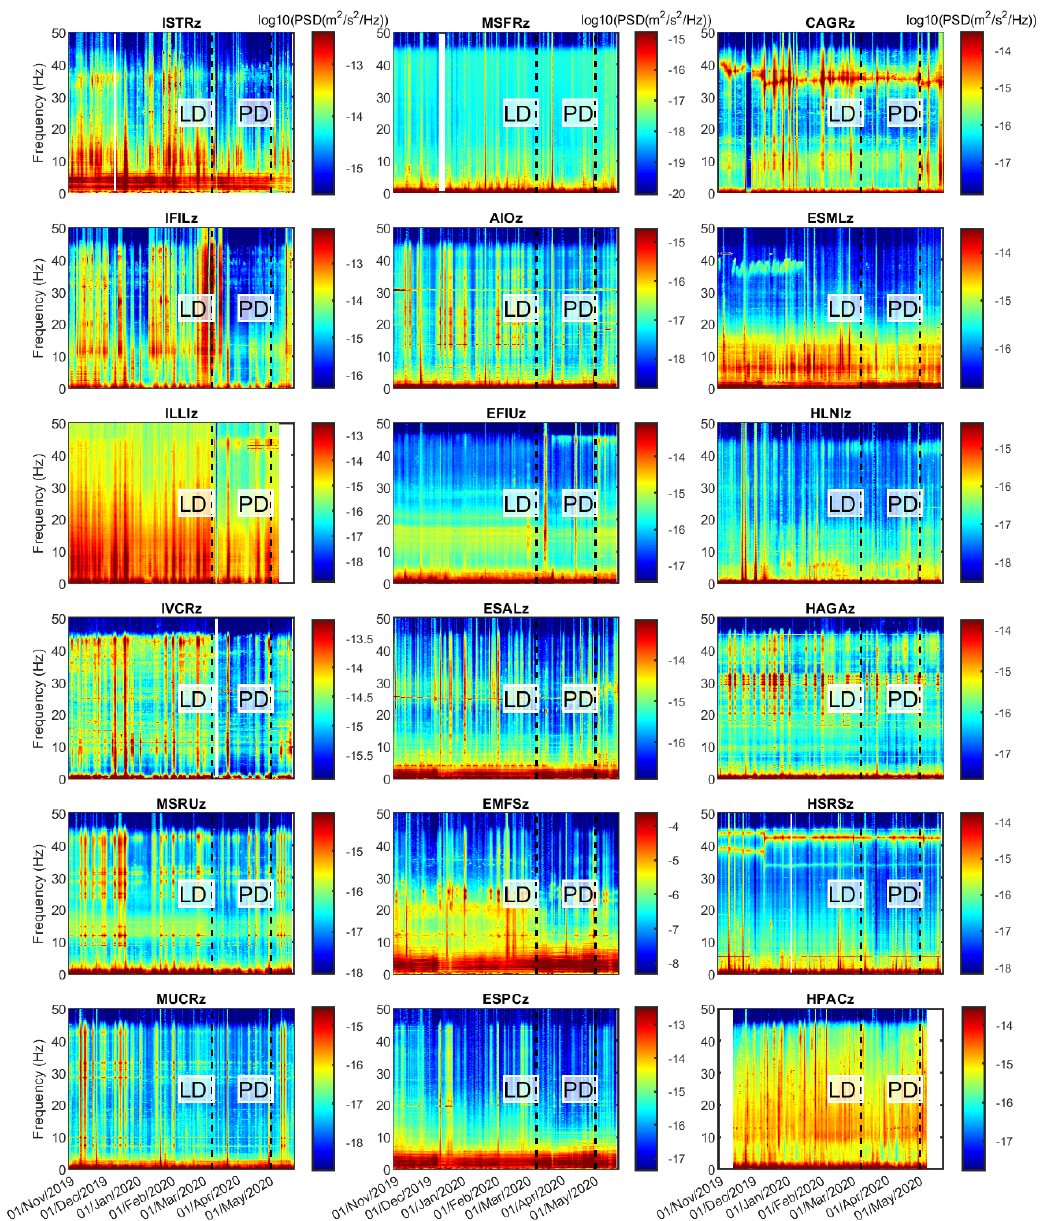
Figure 2. Spectrograms of the vertical component of the seismic signals. The vertical dashed lines and the labels “LD” and “PD” indicate the times when the national lockdown measures were implemented in Italy (11 March 2020) and when the first presidential decree, slightly lifting the lockdown measures, was issued (4 May 2020), respectively. The stations are sorted by decreasing latitude from upper left to bottom